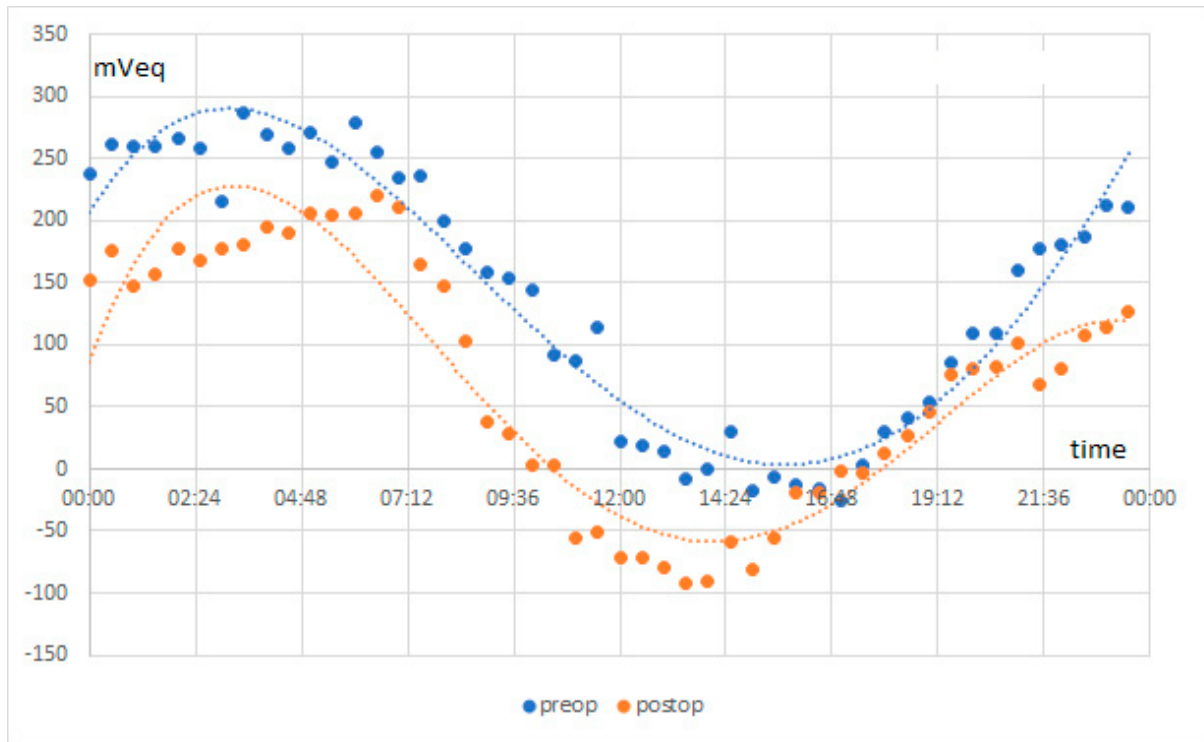
Figure 4. Star diagram with IOP values in mmHg before and after the operation for each subject.